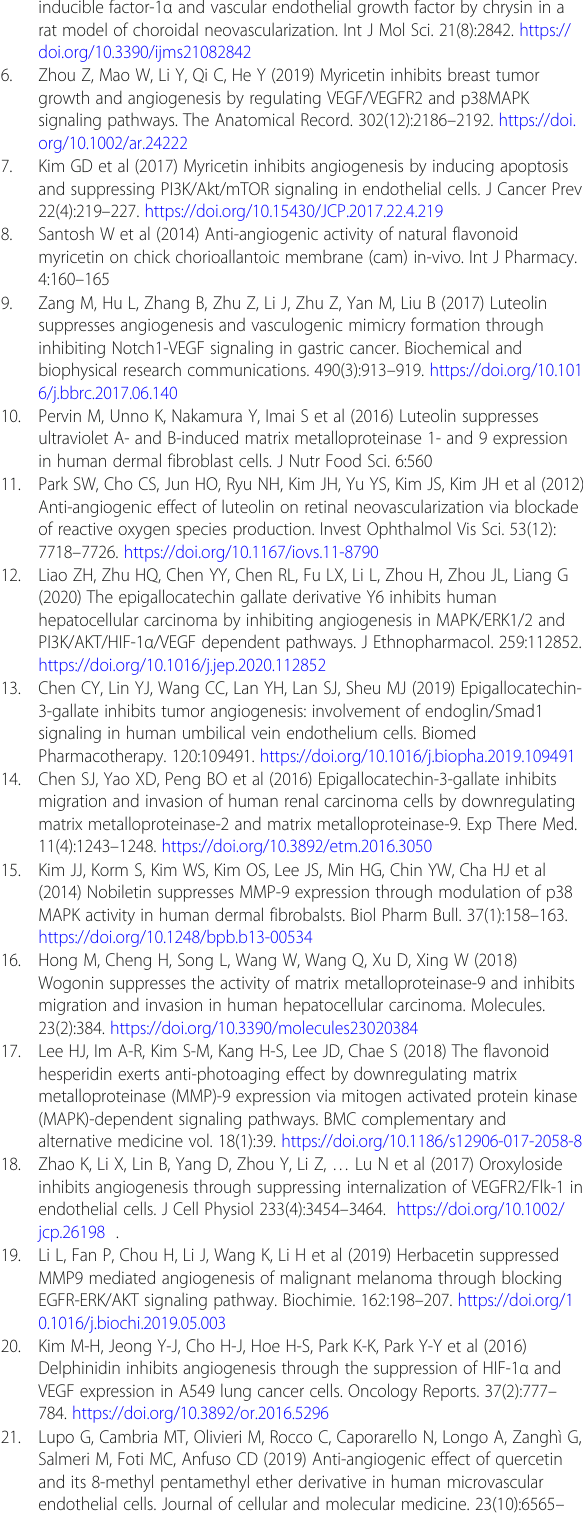
Abbreviations VEGF: Vascular endothelial growth factor; VEGFR: Vascular endothelial growth factor receptor; bFGF: Basic fibroblast growth factor; HIF-1 α : Hypoxia- inducible factor-1 α ; MMP: Matrix metalloproteinases; HUVEC: Human umbilical cord vascular endothelial cells; EGFR: Epidermal growth